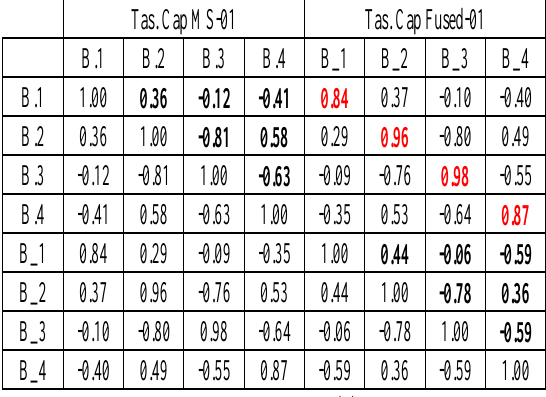
Table 5. Correlation matrix between the bands (B) of MS-01 image (B.1-B.4) and fused image-01 (B_1-B_4).